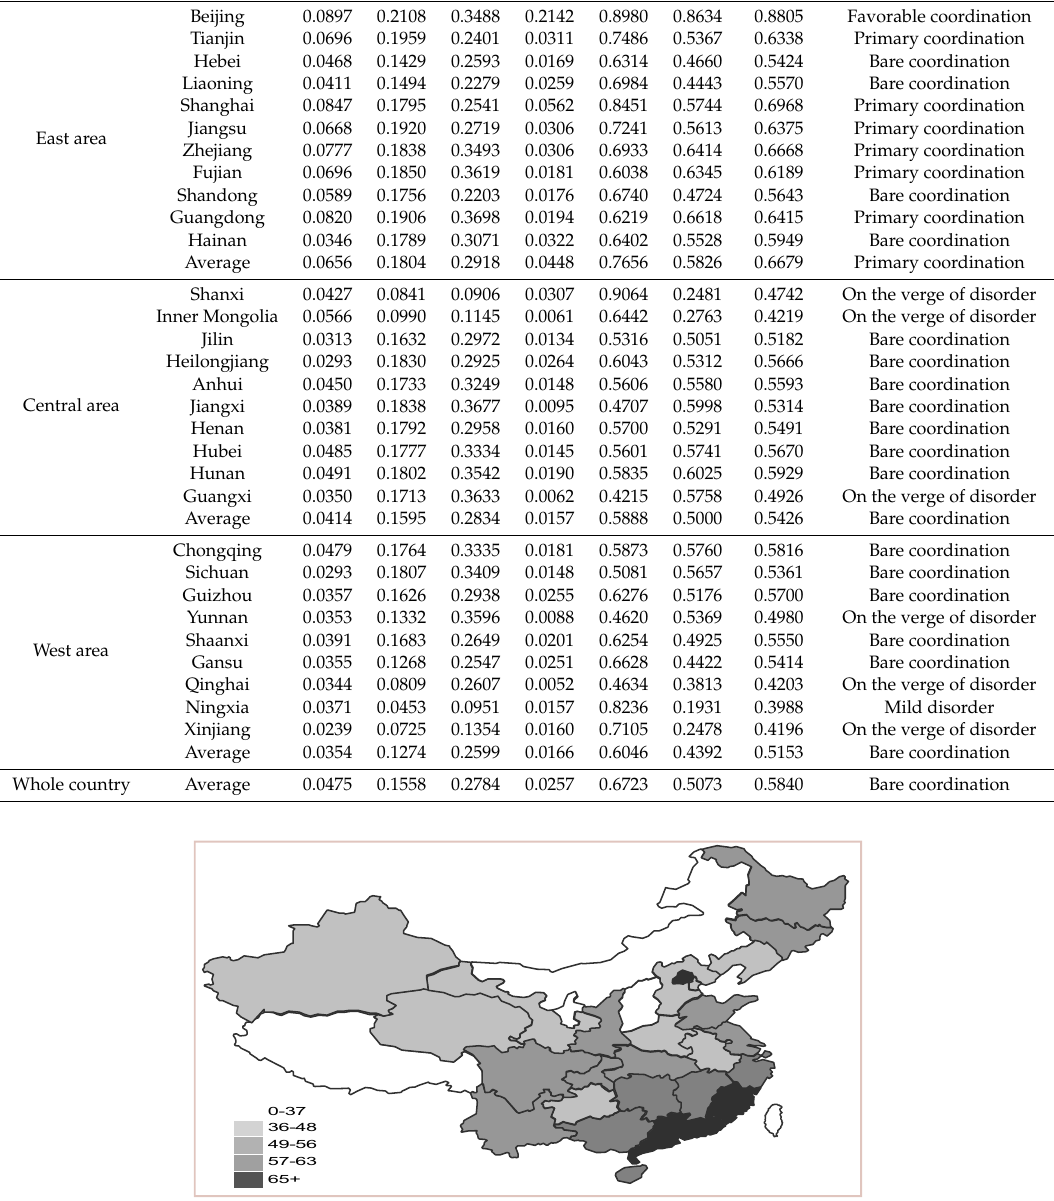
Figure 2. Cluster analysis map of low-carbon economy level of China.